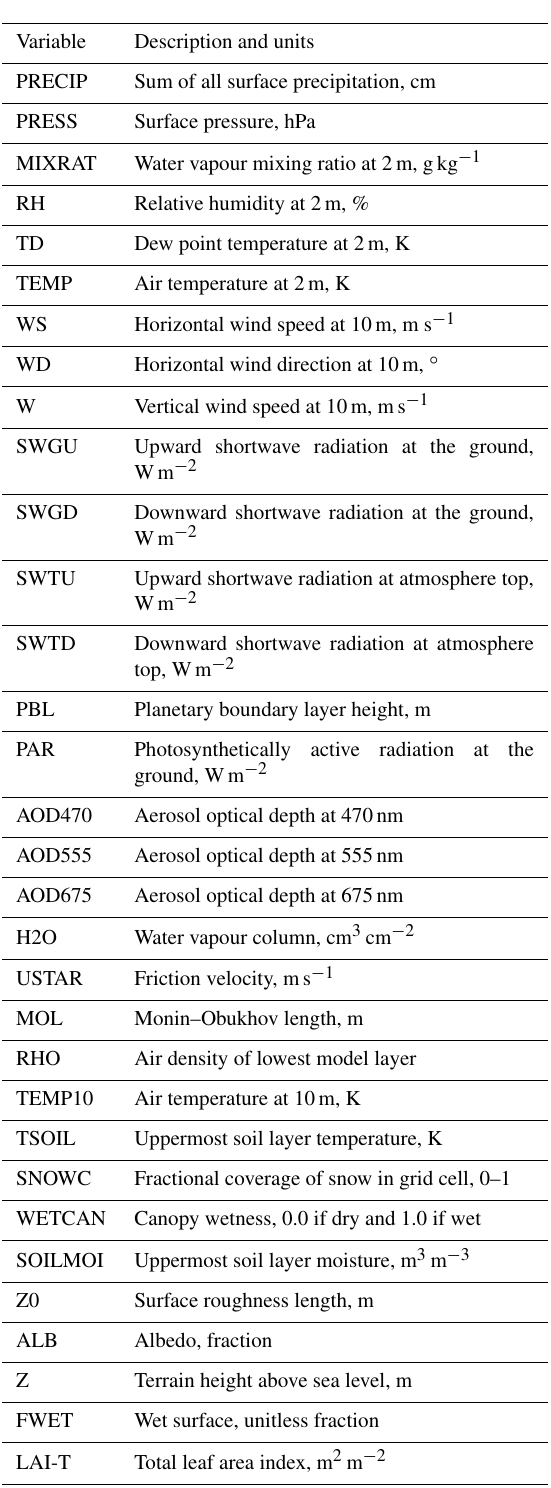
Table A1. AQMEII4 – meteorology (grid).